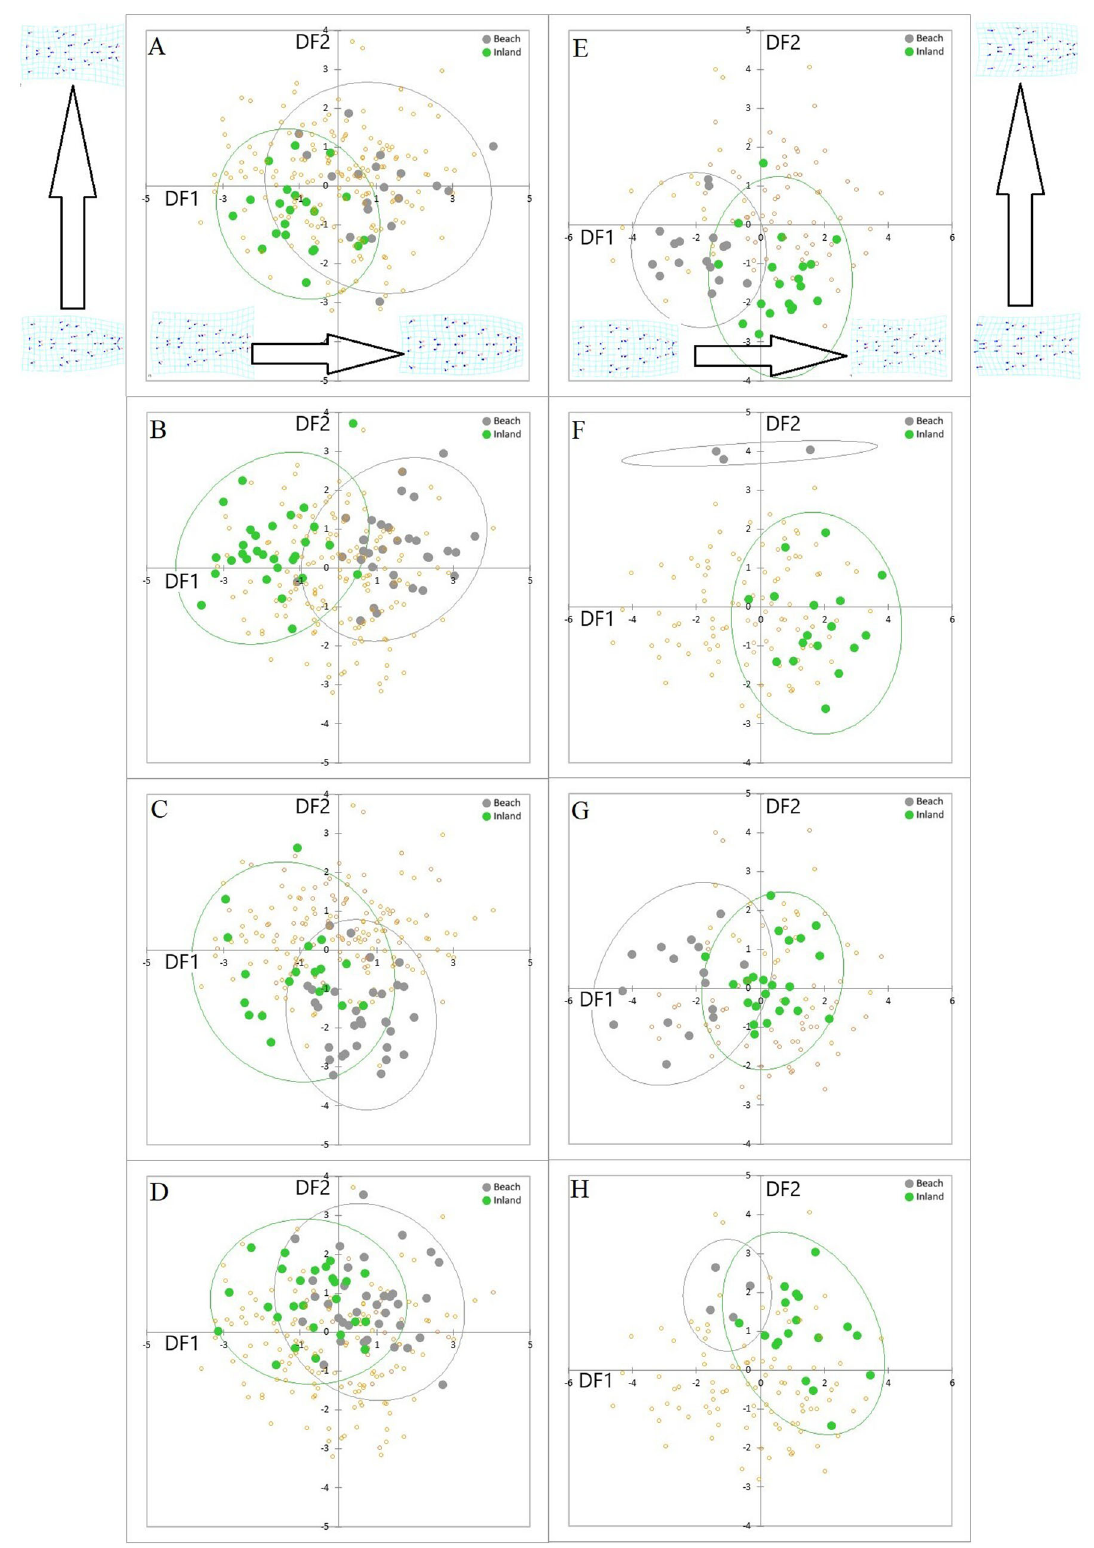
Fig. 2 Lizard head shape. Plots of DF1 and DF2 scores from discriminant function analyses of head shape for localities 1-4 for the male ( A – D ) and female ( E – H ), with 95% con fi dence ellipses. Plots A and E correspond to locality 1, plots B and F to locality 2, C and E to locality 3, and D and H to locality 4. For males, DF1 and DF2 represented 38.5 and 18.4% of the total variation and positive DF1 scores correspond to wider snouts while corresponding values for females (plots E – H ) were 26.2 and 20.3%, respectively, with negative DF1 scores corresponding to wider snouts (the deformation grids indicate how head shape changes along the two axes). The DFAs were carried out across all eight sites, but just the scores for matched pairs of beach and inland sites are highlighted in each plot for clarity (the smaller, transparent points show remaining scores for individuals from other sites). Sample sizes are given in Supplementary Table